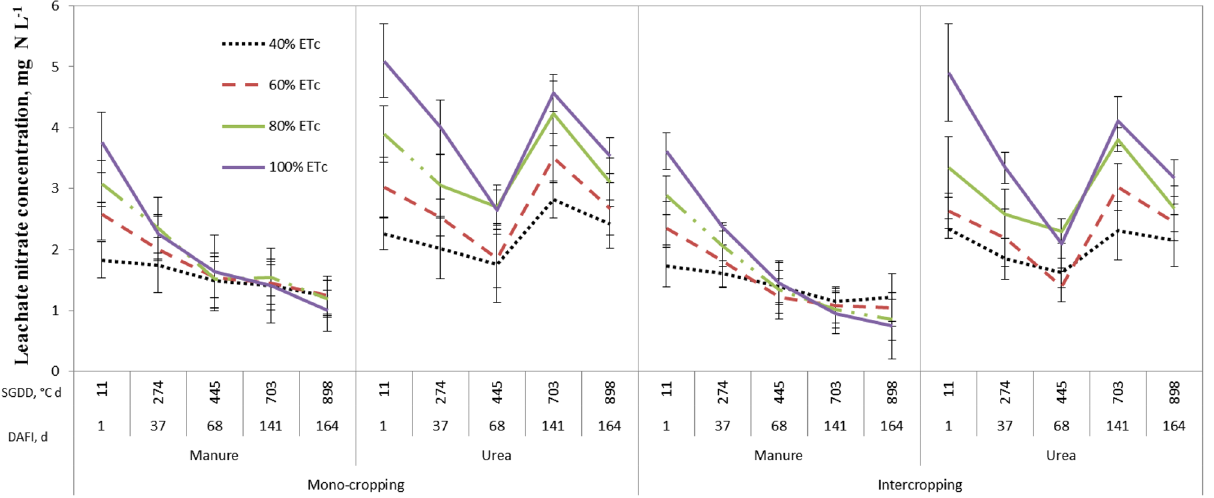
Figure 2. Mean nitrate concentration in the drainage water for different treatments based on both the saffron growing degree-day accumulation (SGDD) and days after first irrigation (DAFI) during the fourth growing